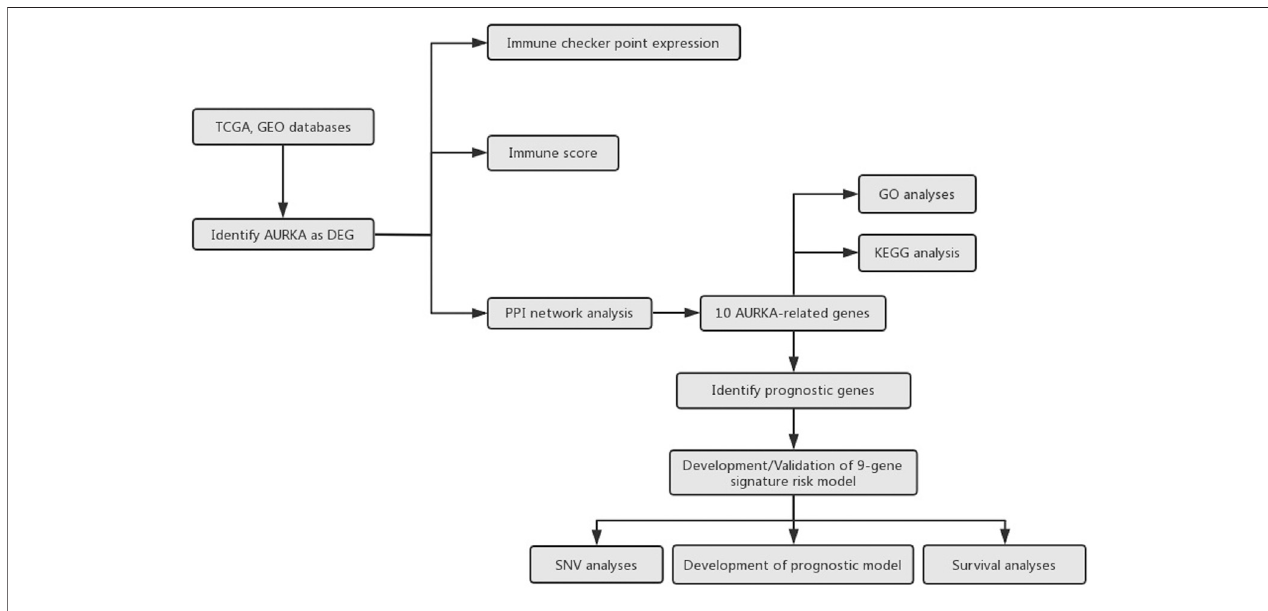
FIGURE 1 | Flow chart of the